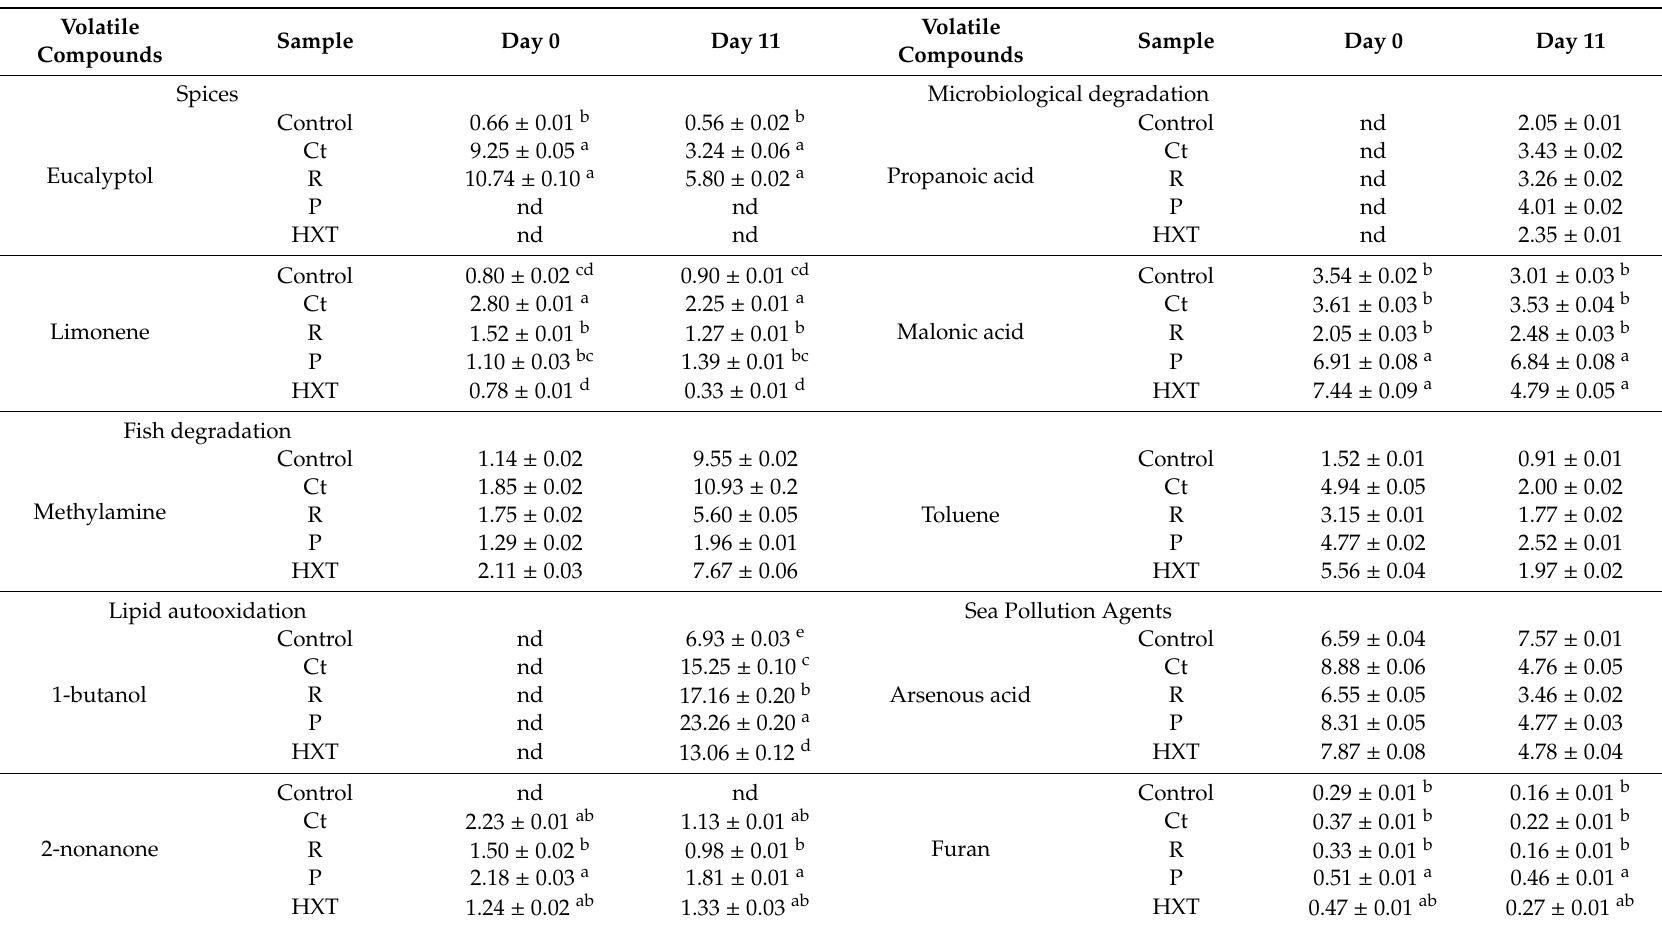
Table 5. Volatile compounds (AU × 10 − 6 per g dry mater) (mean area ± standard deviation) of fish patty samples for 11 days under refrigerated